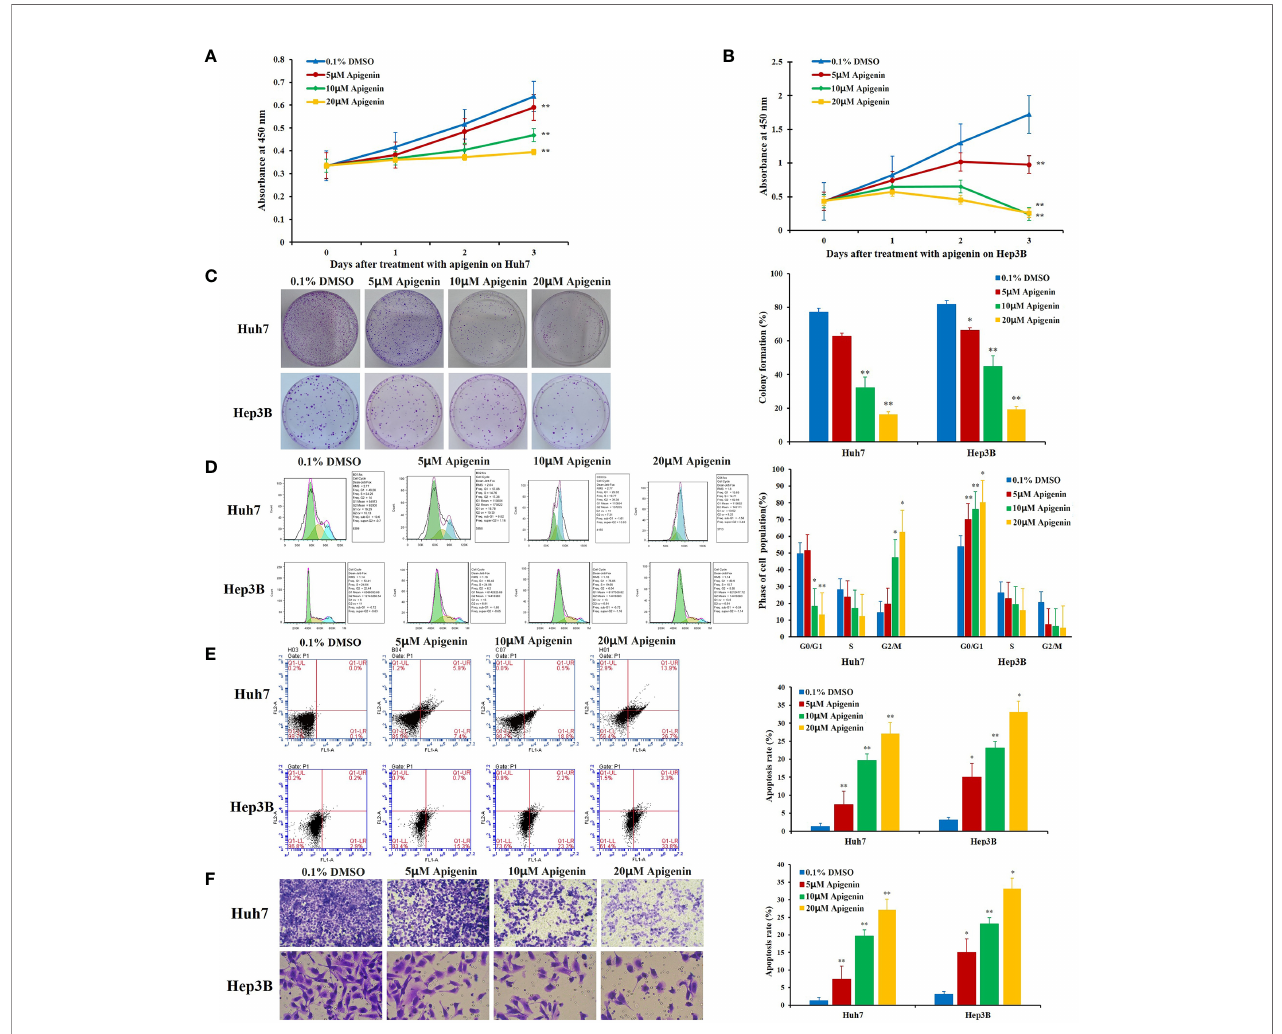
FIGURE 1 | Effects of apigenin on the growth, colony formation, cell cycle progression, and apoptosis rate of Huh7 and Hep3B cells in intro . (A , B) Changes in cell viability as determined by the CCK-8 assay. (C) Colony formation. (D) Cell cycle distribution. (E) Apoptosis analysis by Annexin-V/PI staining. (F) Transwell invasion assay. * P < 0.05, ** P < 0.01, indicating signi fi cant differences in comparison to the control treatment (0.1% DMSO) group. Data are shown as mean ± SD from three independent